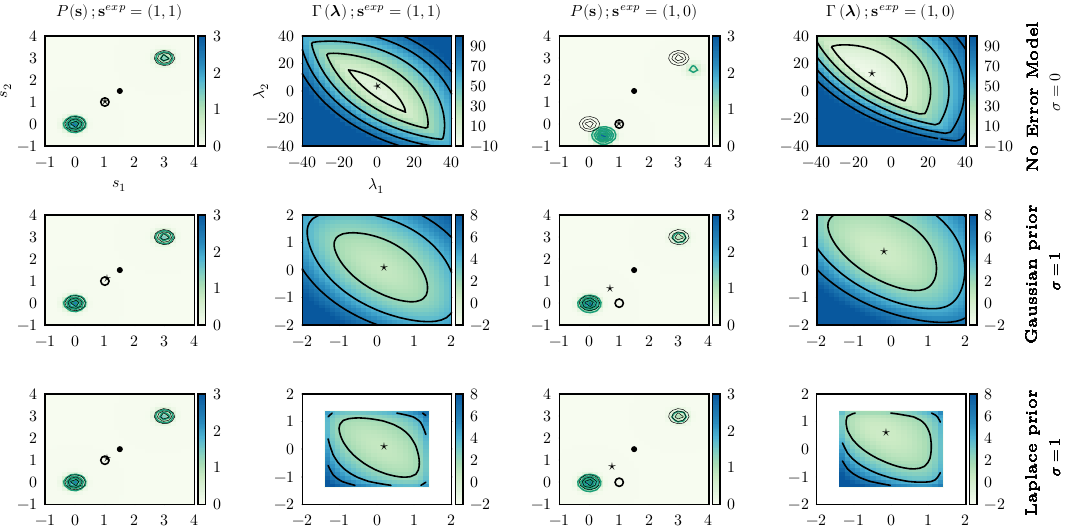
Figure 4. Effect of different prior distributions for the error model in a two-dimensional system. In the first (last) two columns, compatible (incompatible) data are enforced. In the first and the third column, prior distributions are represented as black contour lines and posterior distributions are shown in color scale. A black dot and a (cid:63) are used to indicate the average values of s in the prior and posterior distributions respectively, while an empty circle is used to indicate the target s exp . In the second and the fourth column, the function Γ ( λ ) is shown, and its minimum λ ∗ is indicated with a (cid:63) . The first row reports results where errors are not modeled, whereas the second and the third row report results obtained using Gaussian and Laplace prior for the error model respectively. Notice that a different scale is used to represent Γ ( λ ) in the first row. For the Laplace prior, the region of λ where Γ ( λ ) is undefined is marked as